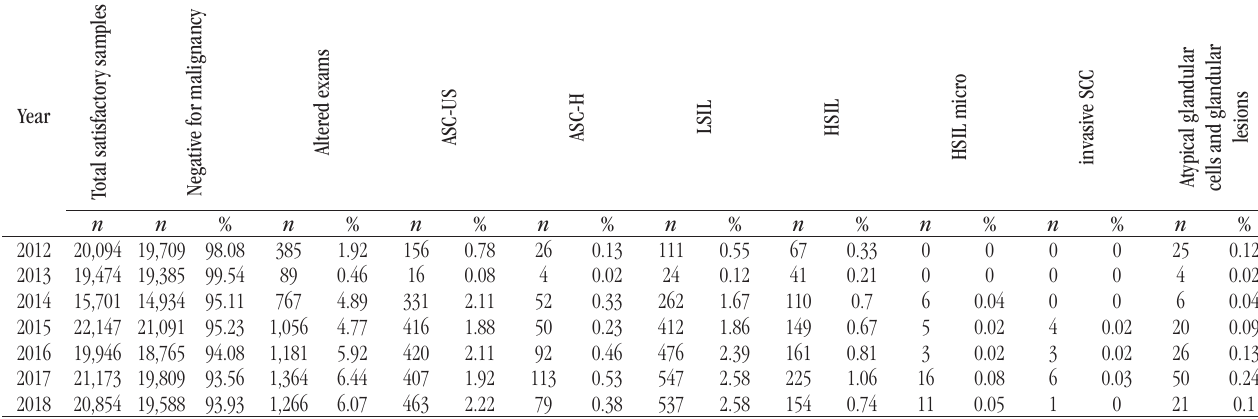
table 2 – Result of cervical cytopathological exams, according to the Brazilian Nomenclature for Cytopathological Reports, underwent by the female population using SUS, in the municipality of Cascavel, Paraná, between 2012 and